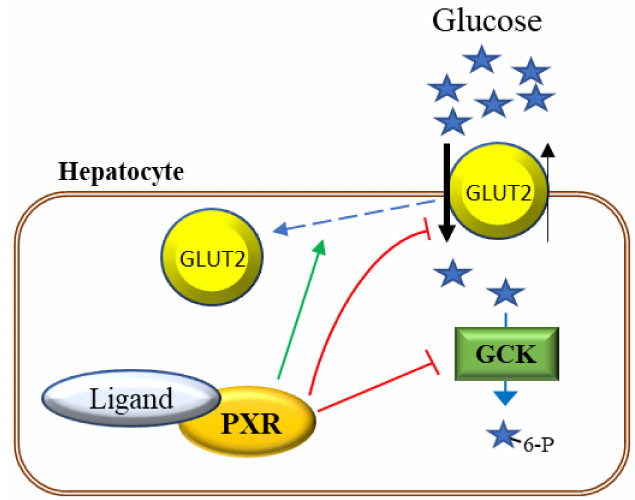
Figure 1. Mechanisms mediating the e ff ect of PXR activation on hepatic glucose uptake. In the postprandial state, GLUT2 glucose transporter facilitates glucose uptake into the hepatocytes. In the next step of glucose utilization, glucose is phosphorylated by GCK. Ligand-activated PXR represses expression of both GLUT2 and GCK. PXR activation also relocates GLUT2 from the plasma membrane to the cytosol. Together, these alterations reduce postprandial hepatic glucose